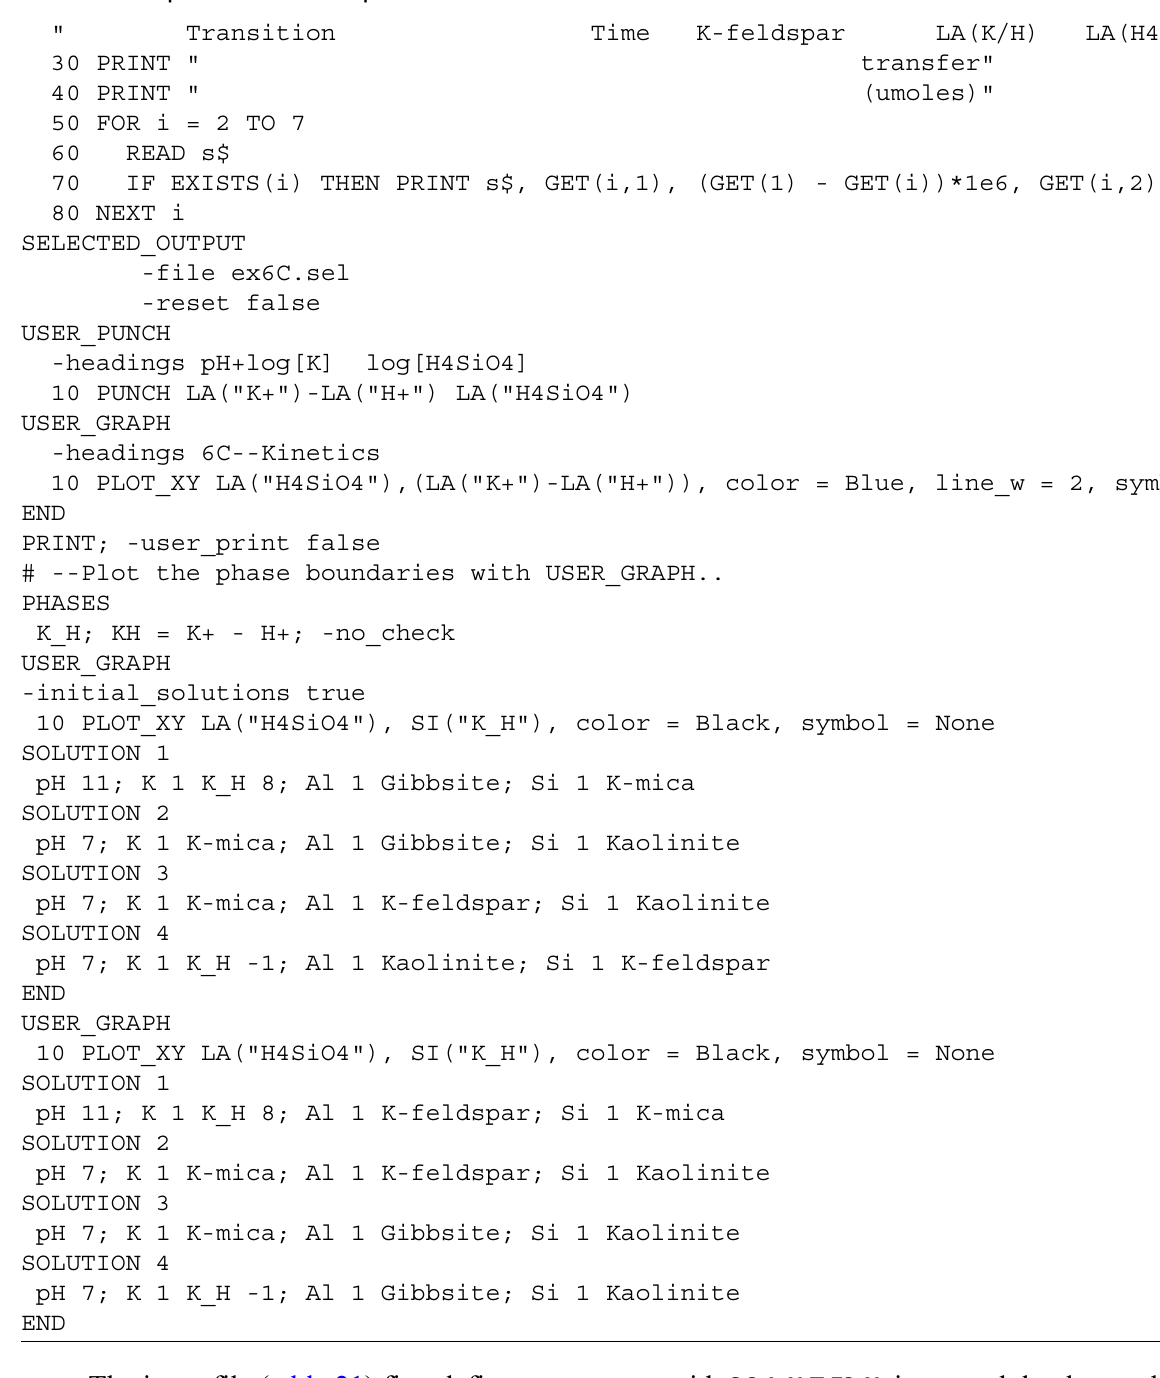
Table 21. Input file for example